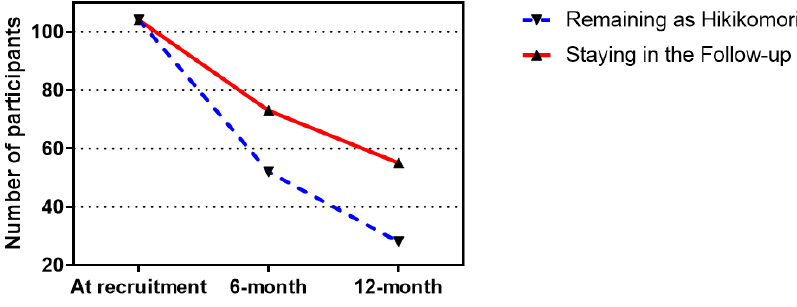
Figure 1. Number of participants at each time point. Table 1. Demographic characteristics of the hikikomori youths followed in the 3 time points.